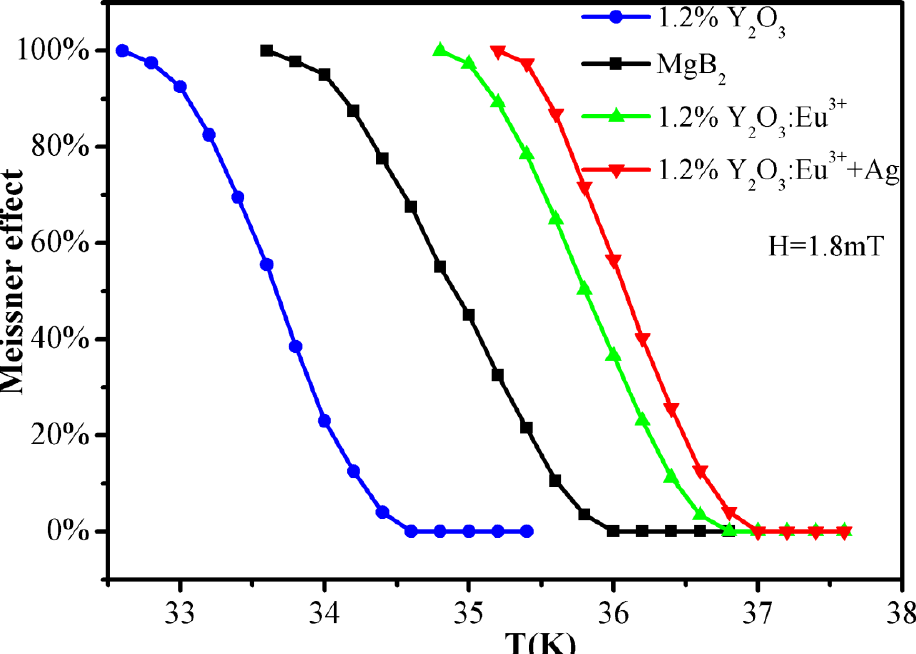
Figure 4. DC magnetization data of pure c MgB 2 and c MgB 2 doped with 1.2 wt% Y 2 O 3 , Y 2 O 3 :Eu 3+ , and Y 2 O 3 :Eu 3+ +Ag.